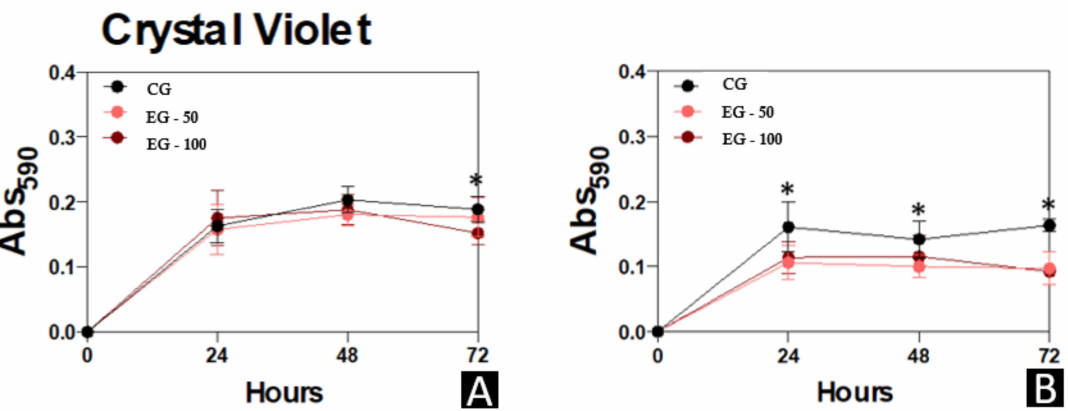
Figure 5. Biofilm formation by C. albicans and S. mutans for 24, 48, and 72 h at 37 ◦ C. ( A ), C. albicans . ( B ), S. mutans. At each time point evaluated, the systems were processed to detect biomass by incorporating a crystal-violet solution at 590 nm. Results are expressed as the mean ± standard deviation of three independent replicates. * p < 0.05.